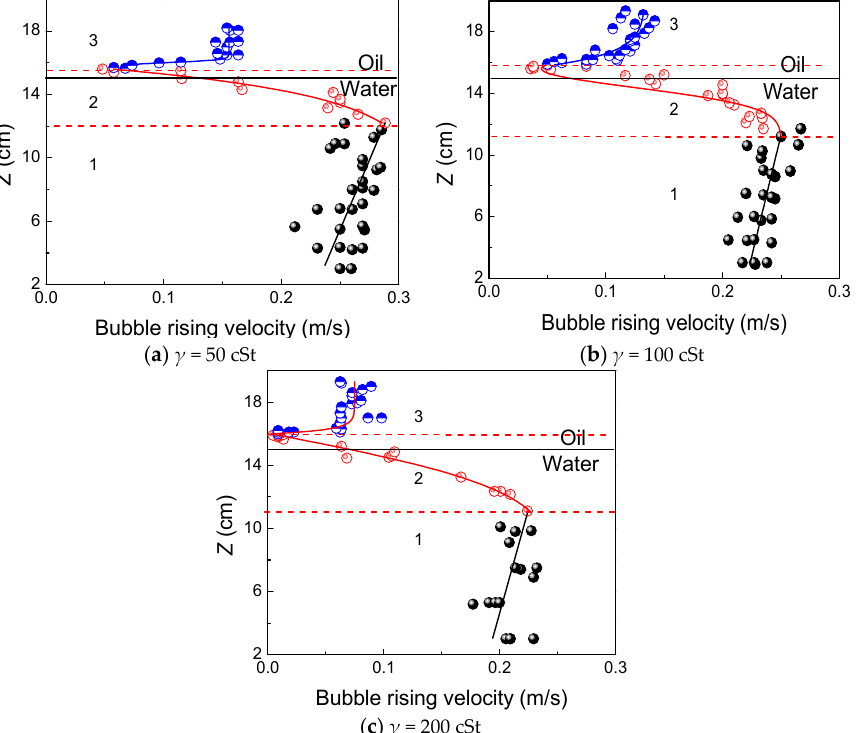
Figure 5. Rising-bubble velocity distribution ( Q = 50 mL/min).